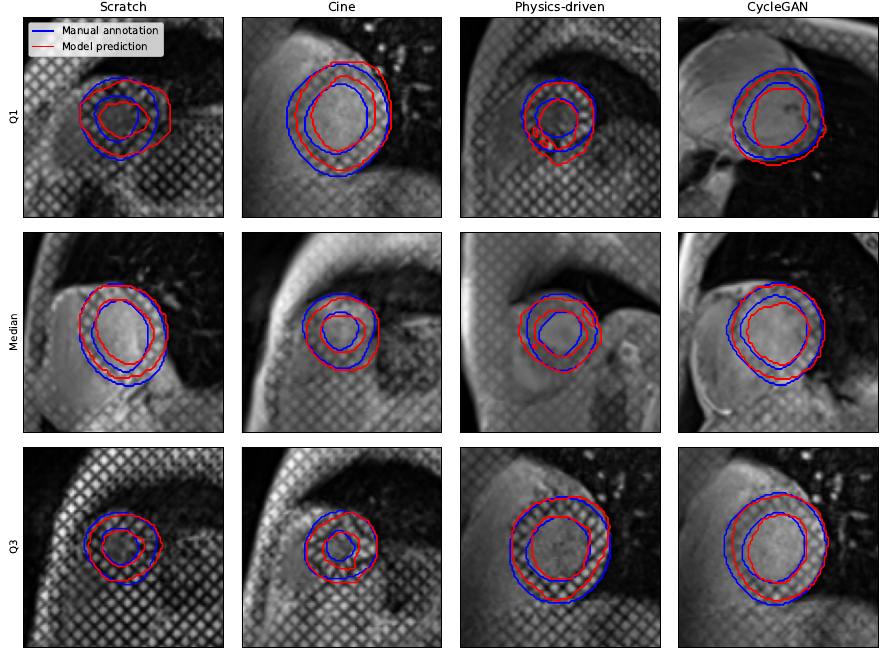
Figure 6. Qualitative segmentation results for the nnUnet model architecture and different pretraining strategies (with cine images, simulated tagged with physics-driven transformation, and simulated tagged with CycleGAN transformation). The Q1, median, and Q3 examples are chosen from each results distribution based on DSC.